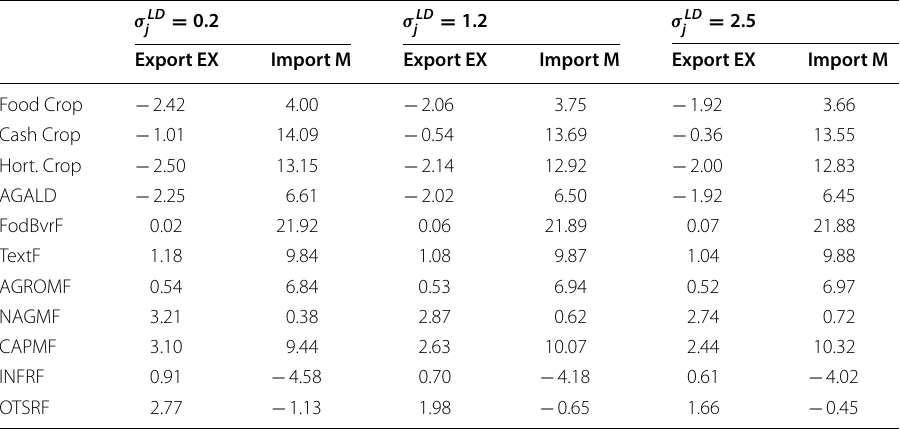
Table 18 (Scenario A2: S1–S3) Change (%) in export–import due to 50% tariff reduction (no segmentation labour